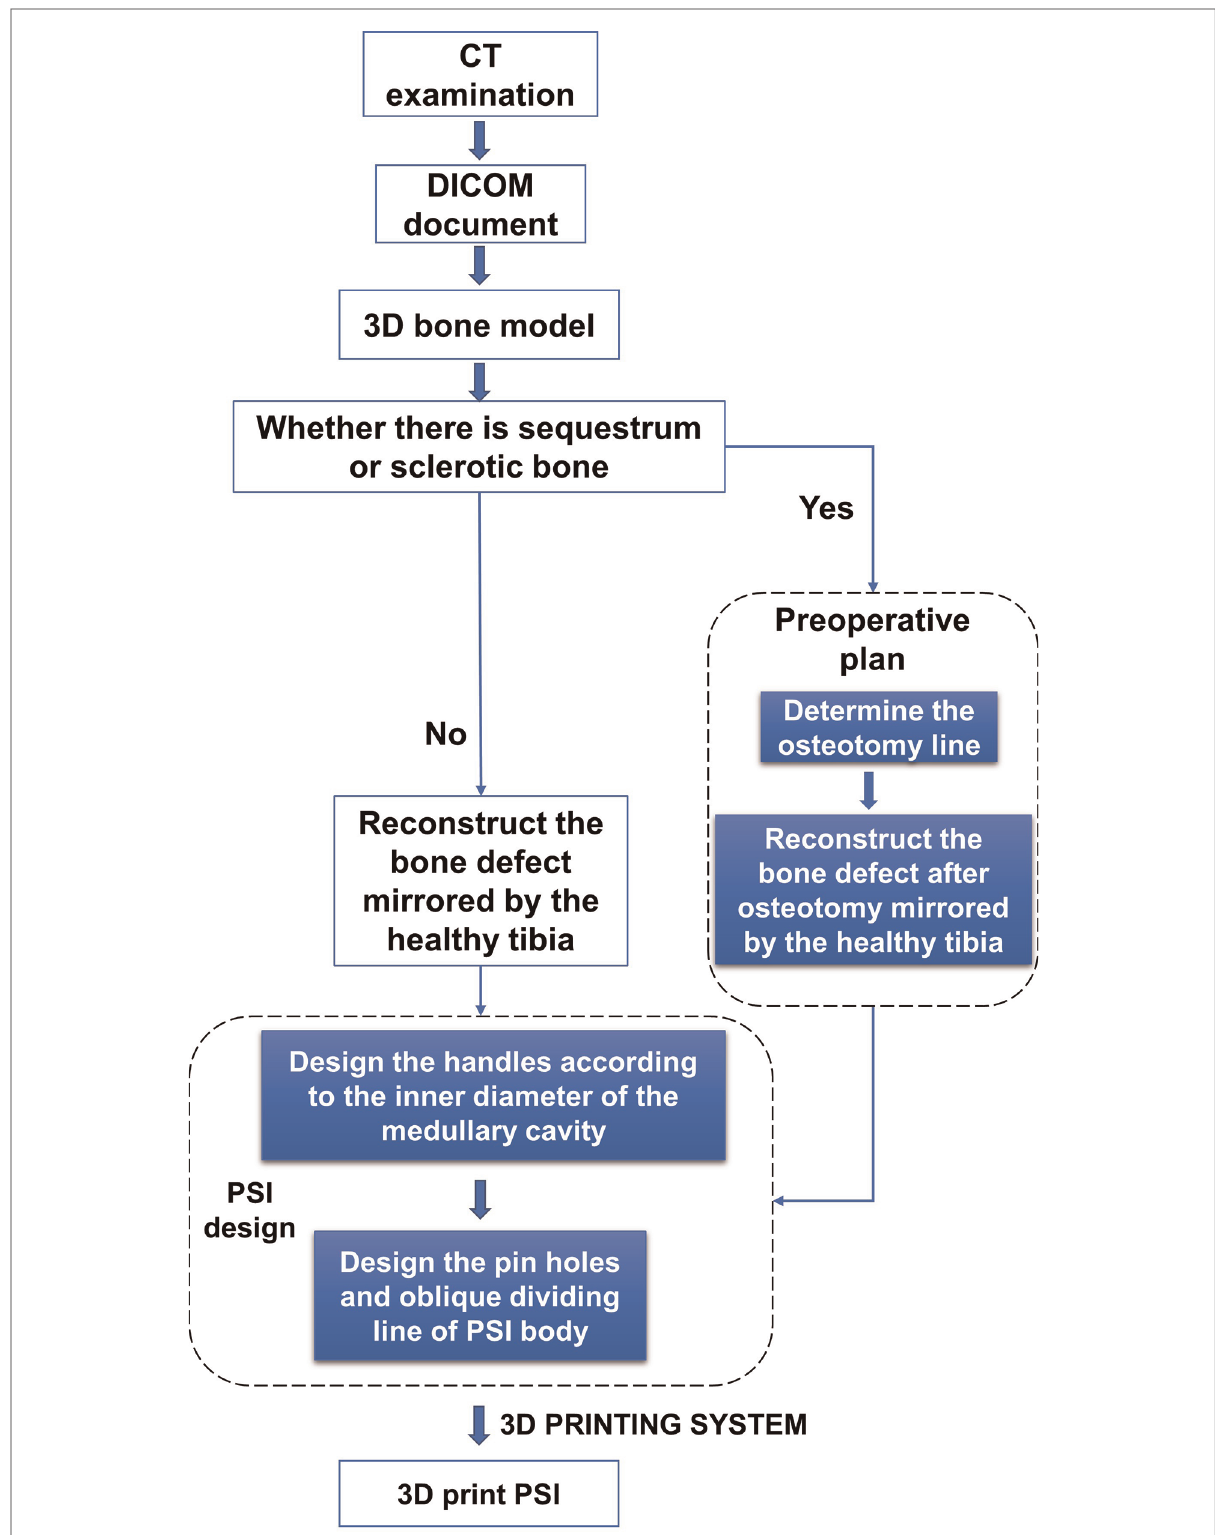
FIGURE 1 The design procedure of